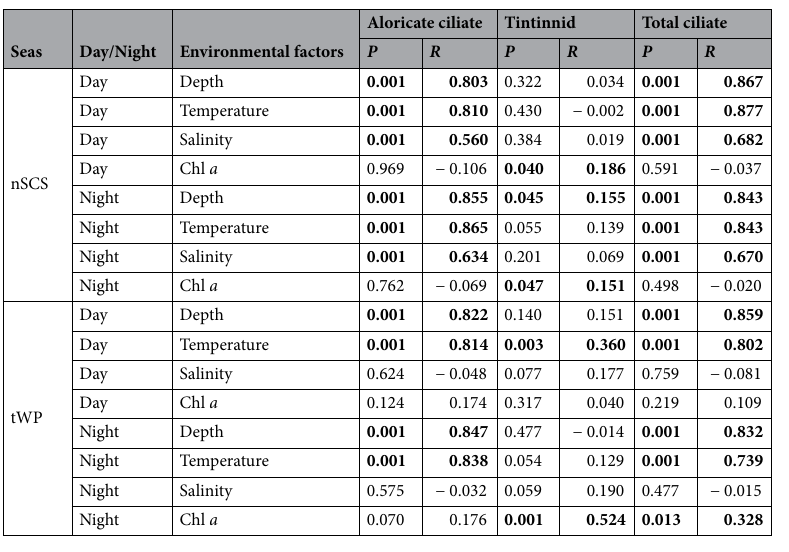
Table 1. Partial Mantel tests comparison between ciliate community (aloricate ciliate, tintinnid, and total ciliate) and environmental factors (depth, temperature, salinity, and Chl a ). Numbers in bold indicate statistically significant results.